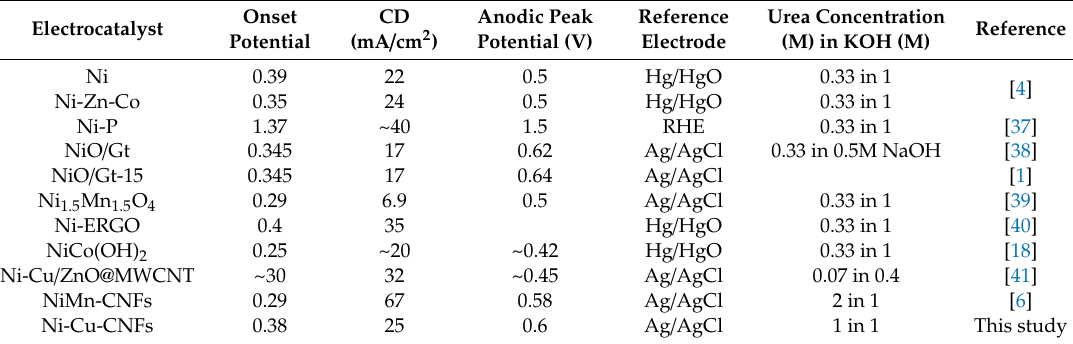
Figure 8. ( A ) CV of NiCu-CNF electrodes in 1 M KOH solution before and after adding 1 M urea solution at 50 mV / s and ( B ) study the influence of glass carbon electrode, graphite, Cu NPs, and Ni-Cu CNFs on urea electroxidation (1 M urea + 1 M KOH, scan rate of 50 mV / s). Table 1. CD values of di ff erent